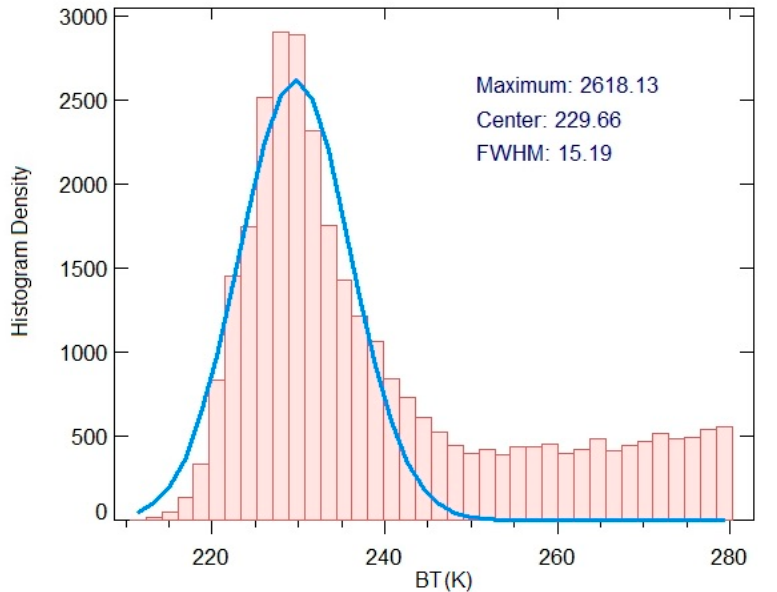
Figure 18. Histogram of BTs for typical hailstorm events by using the Gaussian fitting method over the Beijing region.